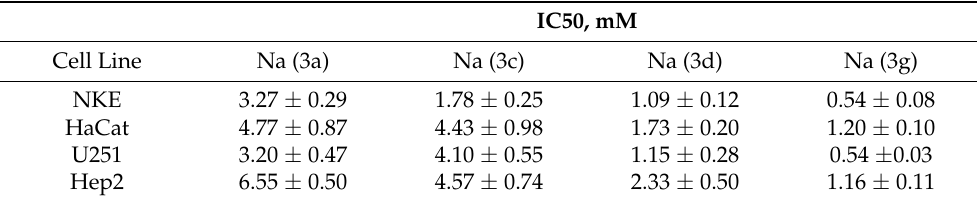
Table 1. Comparative results of MTT